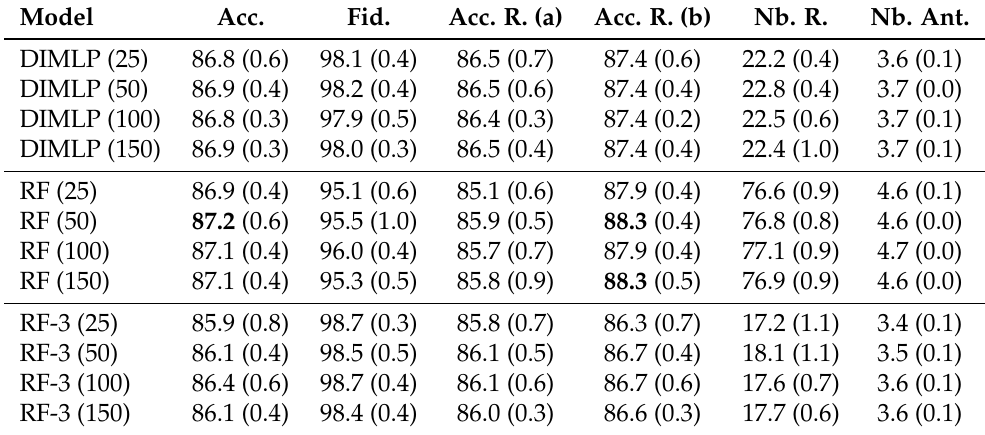
Table 2. Average results obtained on the “Australian” dataset. From left to right are presented the average results on predictive accuracy, fidelity on the testing sets, predictive accuracy of the rules, predictive accuracy of the rules when ensembles and rules agreed, number of rules, and number of antecedents per rule. Standard deviations are given between brackets. For DIMLP, RF, RF-3, and RS, the number of predictors is given between brackets (first column). For GB, the first number in brackets is the depth of the trees and the second is the number of predictors. For each column, the highest average accuracy or average fidelity is represented in bold, along with the lowest average number of rules or average number of